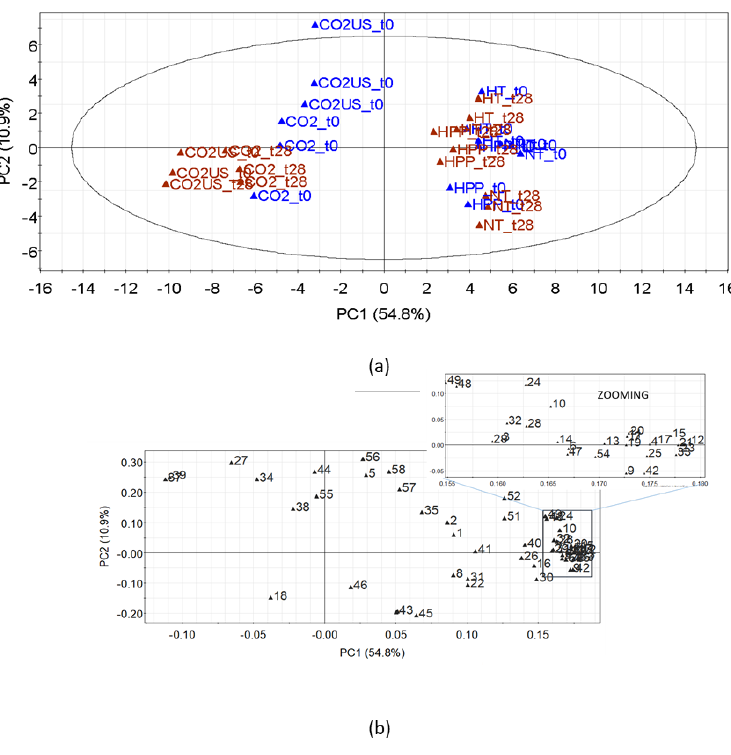
Figure 5. PCA of SPME / GC-MS data for juices at t 0 and t 28 . ( a ) Score plot of the first two components on standardized results. ( b ) Loading plot of the first two components on standardized results; numbers correspond to volatile compounds reported in Table 3.